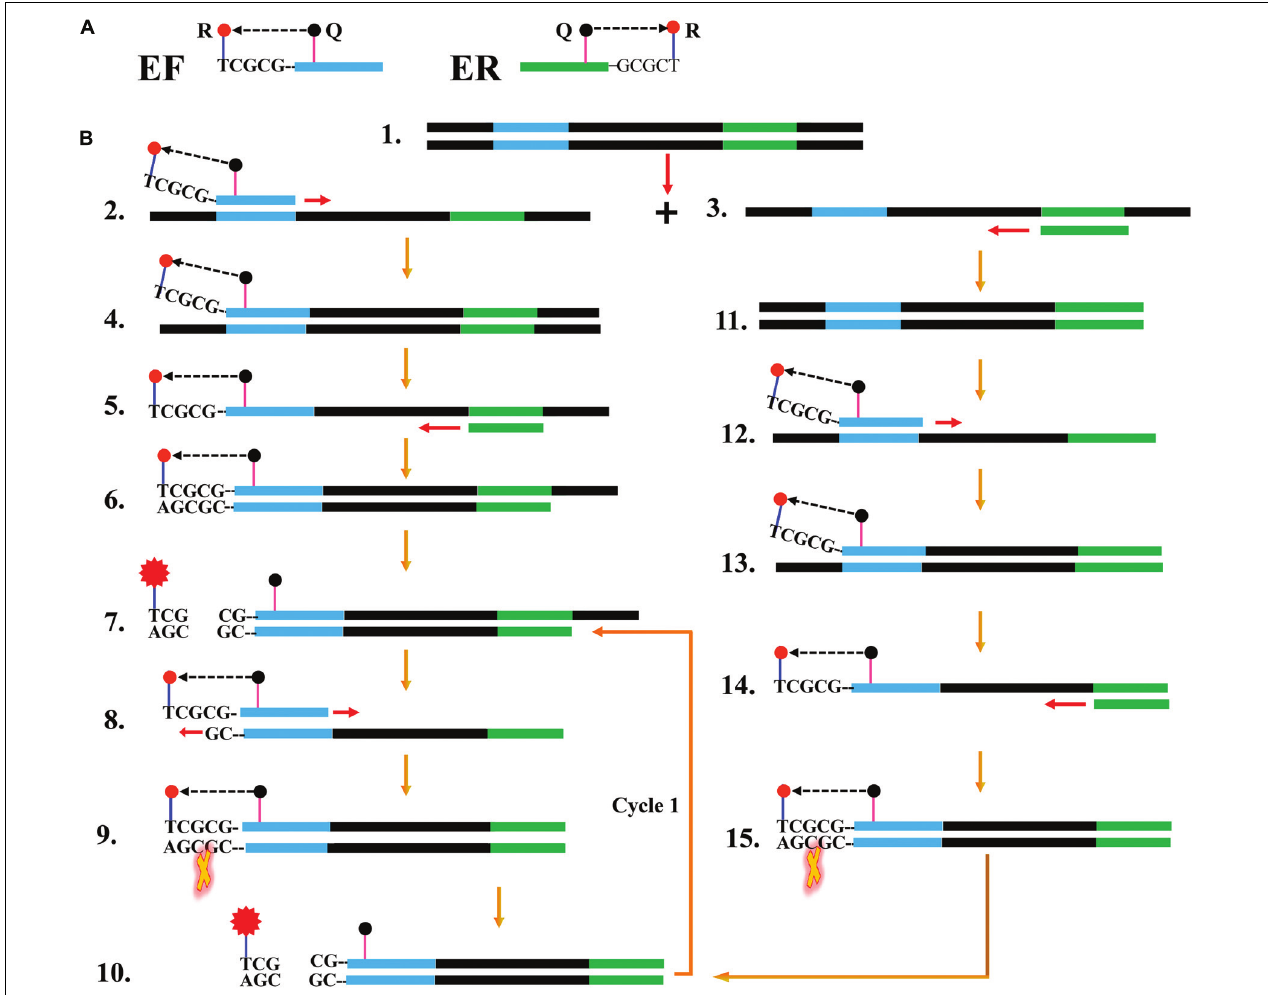
FIGURE 1 | Reaction mechanism of endonuclease restriction-mediated real-time polymerase chain reaction (ET-PCR). (A) The schematic depiction of a new forward/reverse primer (EF/ER). EF/ER primer, which is an extension of the conventional forward (F)/reverse (R) primer with a short sequence (Ss, 5 (cid:48) -TCGCG-3 (cid:48) , its complementary sequence termed Cs) at the 5 (cid:48) end, contained a reporter dye (R) at the 5 (cid:48) end and a quencher dye (Q) in the middle. Due to their close proximity, the fluorescence emitted from the reporter molecules was quenched by the quenching dye. (B) Outline of ET-PCR chemistry, with EF and R primers. For clarity, the ER primer was not listed. Firstly, the double-stranded DNA was denatured into single-stranded DNA at high temperature, and the two single-stranded synthetic primers (EF and R) annealed to the target DNA strands (Steps 1–3). The EF primer was extended and the newly synthesized product entered a cyclic two steps process, thus a target double-trended terminal sequence was formed (Steps 4–6). BstUI cleaves the sequence 5 (cid:48) -TCG-3 (cid:48) and its Cs, and the reporter molecule was separated from the quenching molecule leading to a gain of fluorescent signal (Step 7). The double-trended DNA (Step 7) was used as templates for further RT-PCR amplification, resulting gain of exponential fluorescence signals (Cycle1, Steps 8–11). For the R primer, the reaction process was similar to EF primer, and the fluorescence signals also were released in the amplification process (Steps 11–15). The ET-PCR process was repeated in each cycle without influencing with exponential synthesis of the PCR